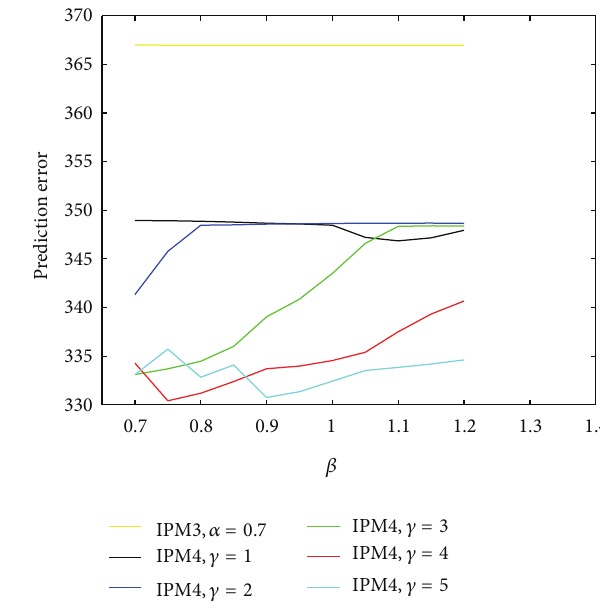
Figure 3: Prediction errors of the new improved parsimonious multivariate Markov chain model with the original convergence condition in sales demand prediction.